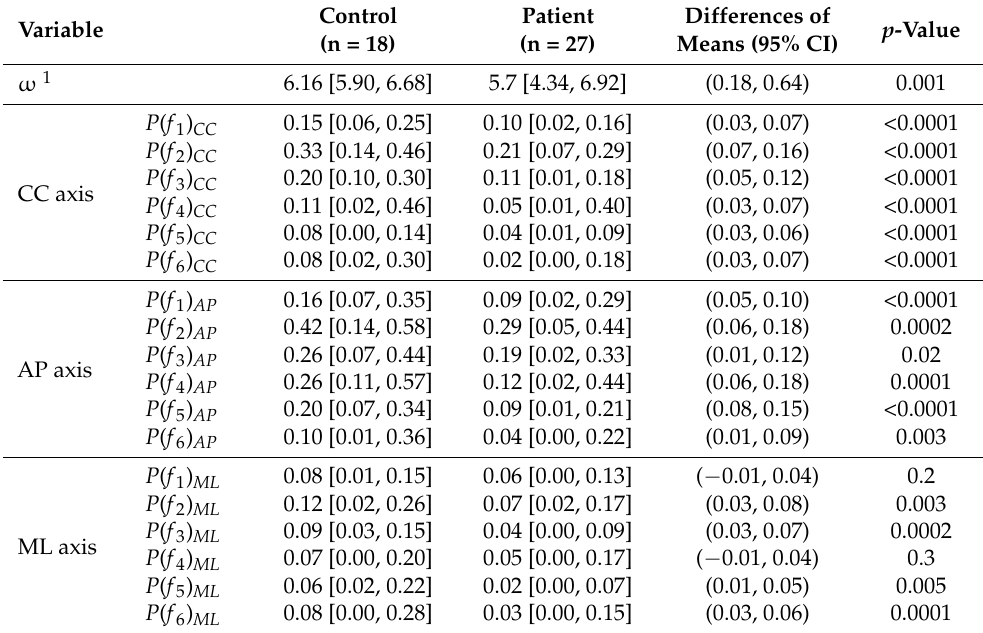
Table 3. The frequency domain features of the acceleration signals in the patients and controls and their 95% confidence intervals of differences of